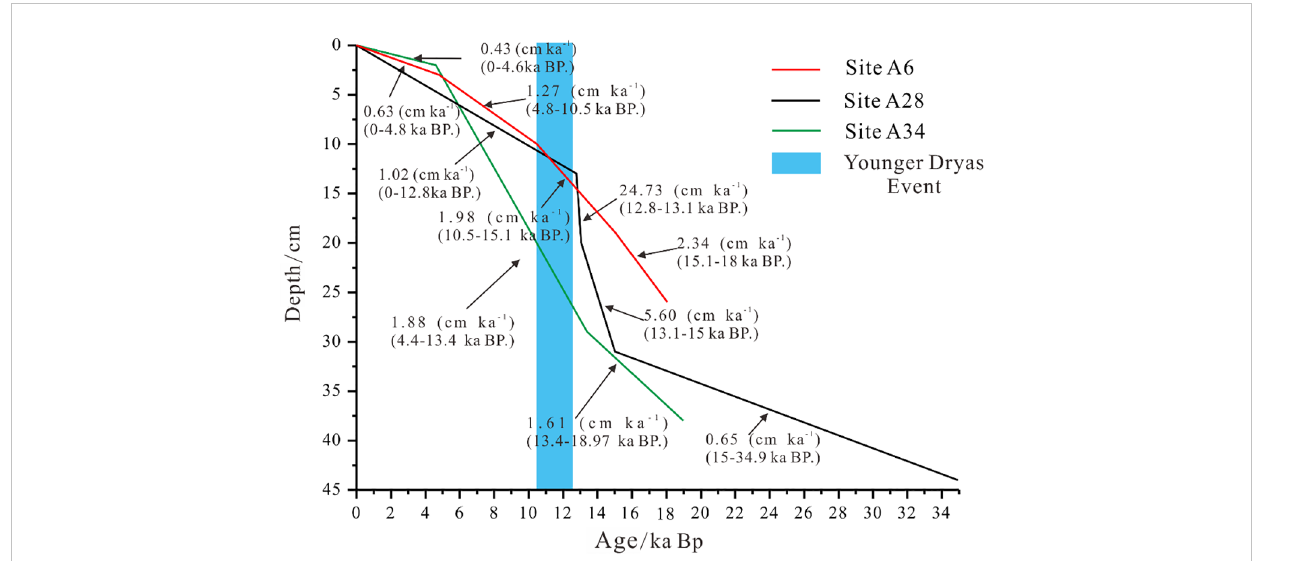
FIGURE 4 Depth versus calibrated calendar age plot of A6, A28 and A34 cores. The linear sedimentation rates are listed for each interval in cm ka -1.